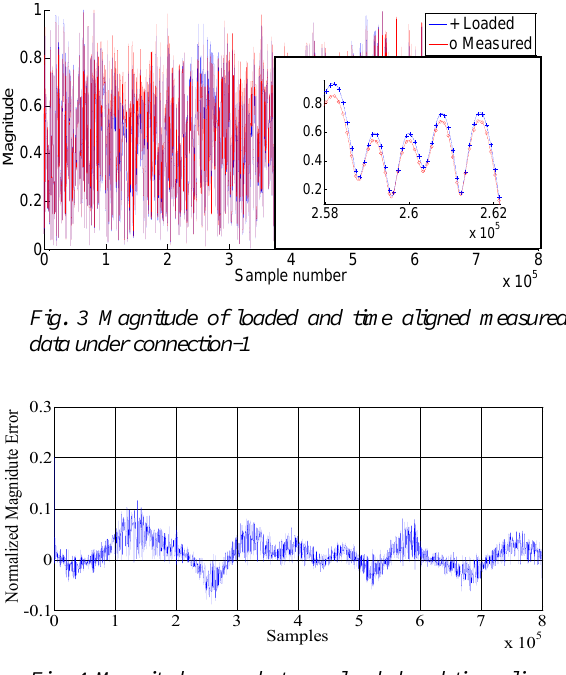
Fig. 4 Magnitude error between loaded and time aligned measured data under